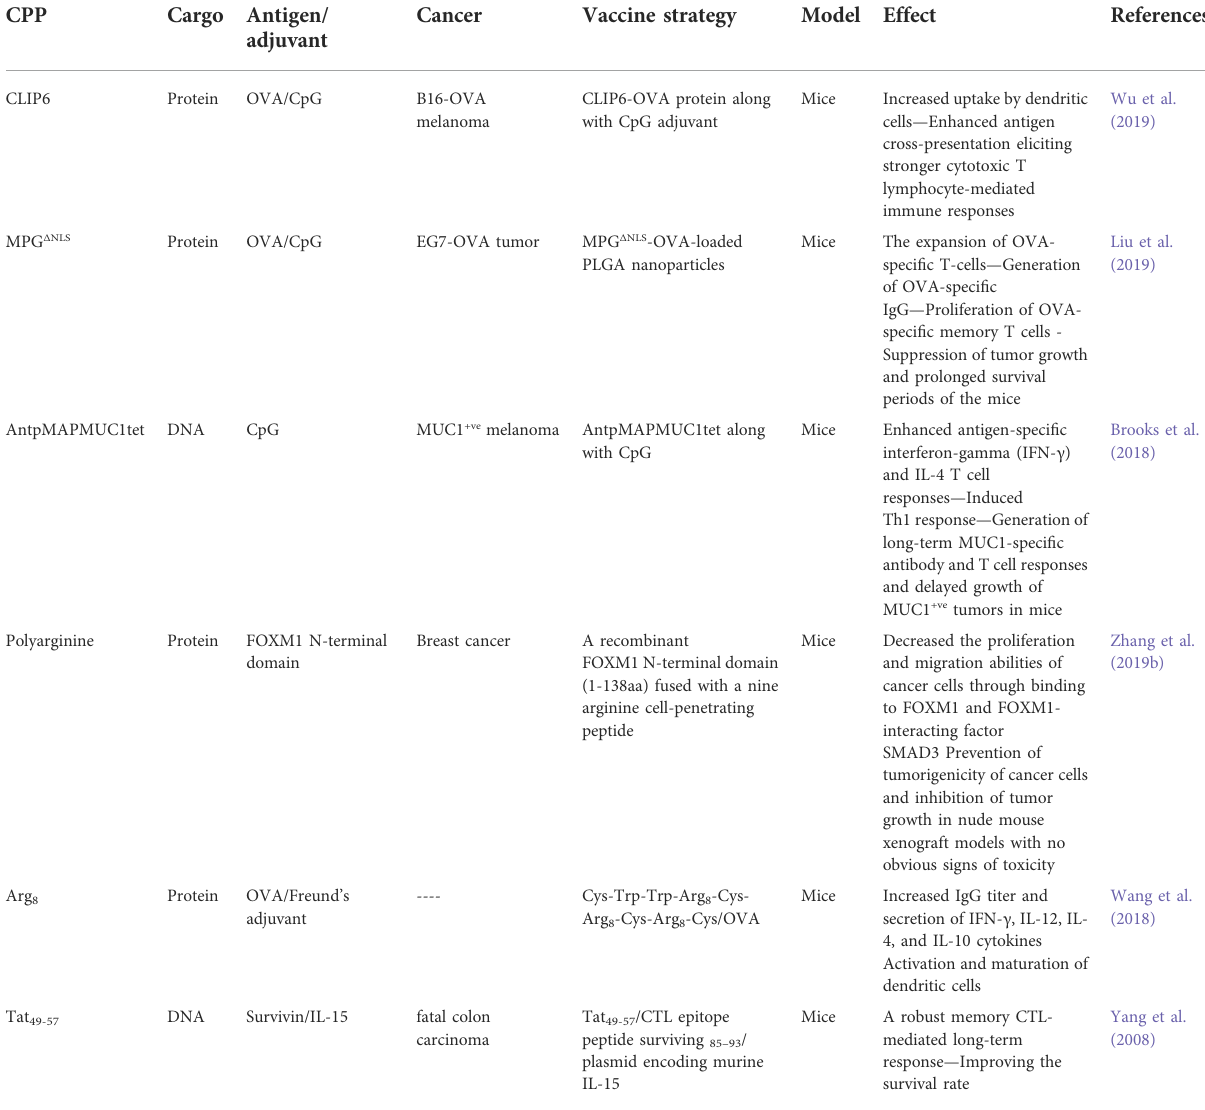
TABLE 2 Examples of different CPP-conjugated vaccines against